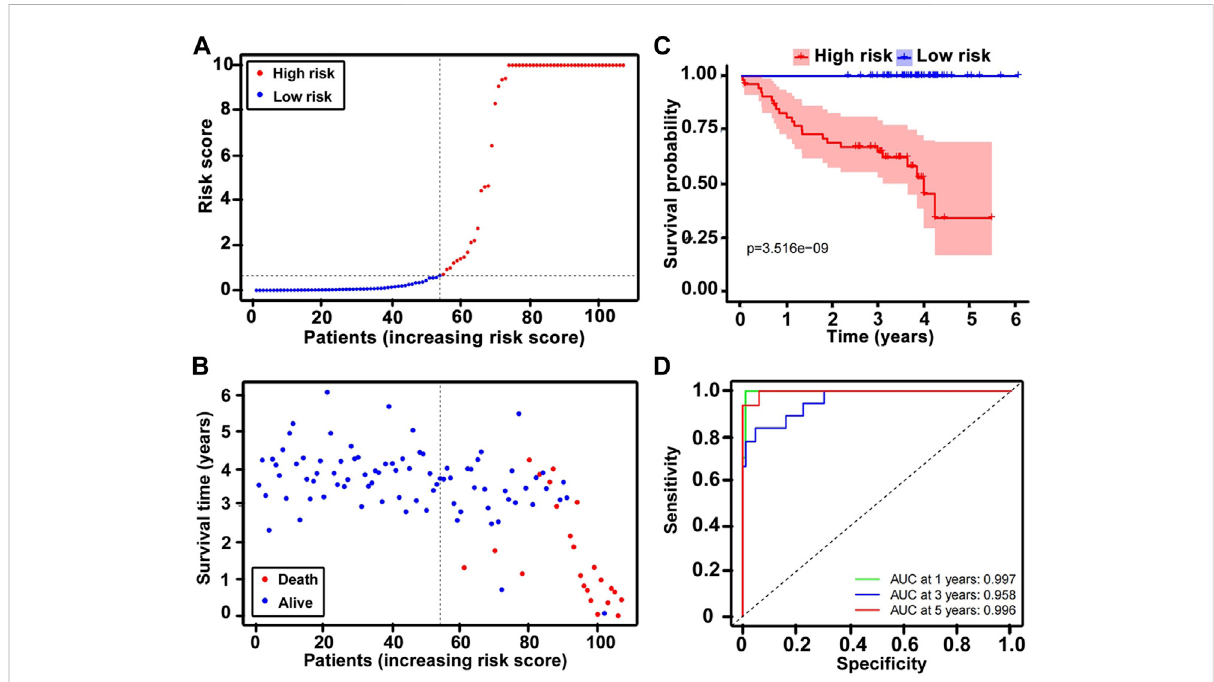
FIGURE 3 Nine-gene prognostic model for the GSE22762 dataset (N = 107, HG-U133_Plus_2). (A) Dot plots comparing the outcomes of subjects in the high- and low-risk cohorts. (B) The survival status and time in the high- and low-risk groups. (C) K – M survival curves showing the differences between the high- and low-risk groups. (D) Time-dependent ROC curve analysis for the prediction survival using the nine-gene model. K – M, Kaplan – Meier; ROC, receiver operating characteristic; AUC, area under the